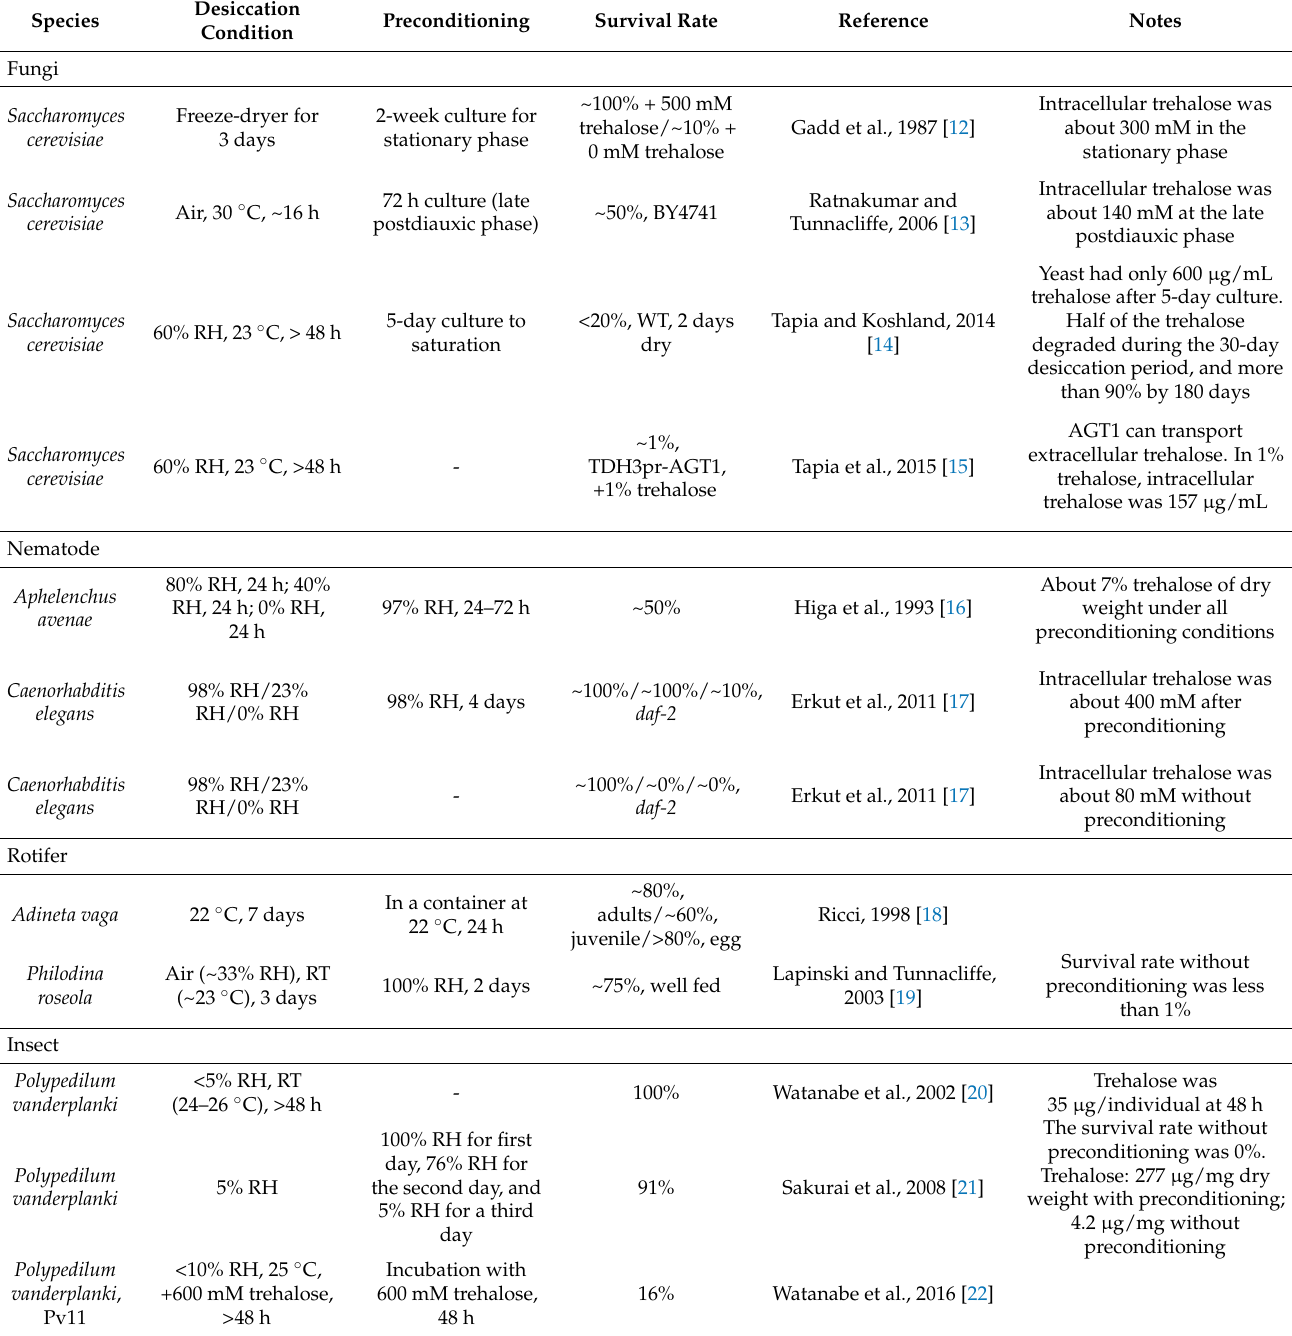
Table 1. Survival of anhydrobiotes under various desiccation